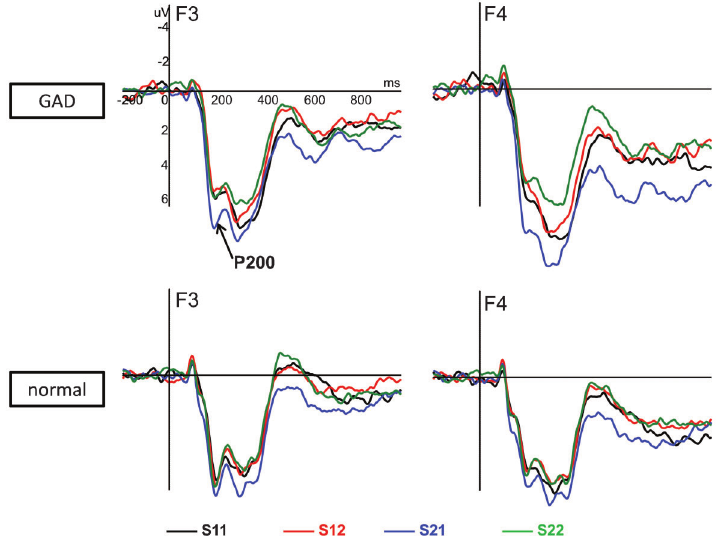
Figure 3. Event-related potentials recorded for patients with generalized anxiety disorder (GAD) and normal controls under S negative/negative , S negative/neutral , S neutral/negative and S neutral/neutral conditions, showing P200 amplitude at the site of F3 and